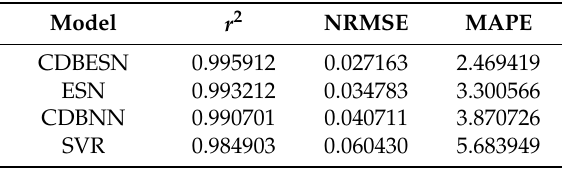
Table 1. Forecasting results of the CDBESN, ESN, CDBNN, and SVR models in the testing